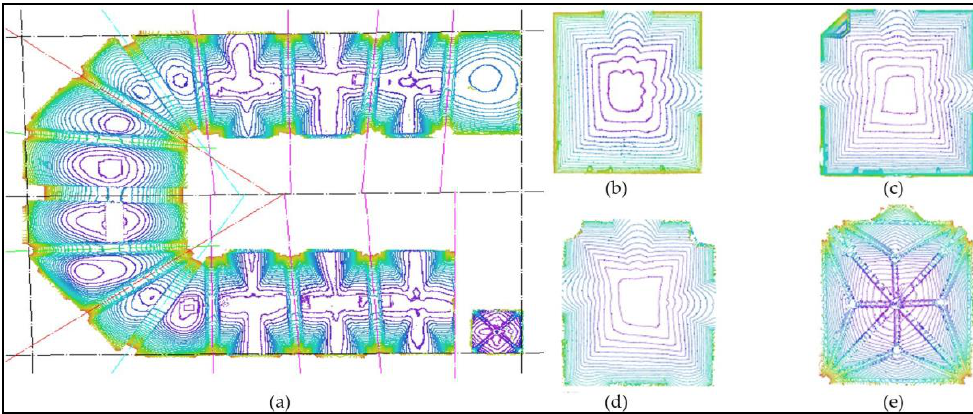
Figure 23. Height contour geometry of the vaults in the Tower of Belém: ( a ) Bulwark vaults – Level N00; ( b ) Level N02; ( c ) Level N03; ( d ) Level N04; ( e ) Level N05.